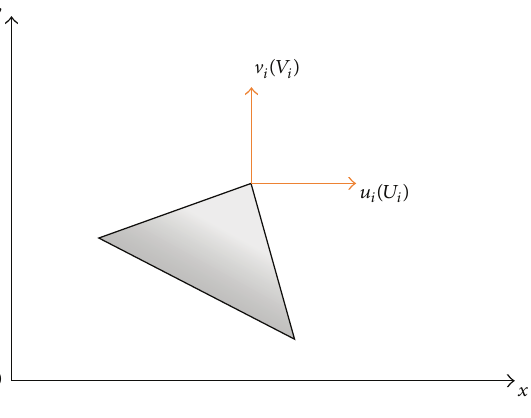
Figure 3: A single-grid